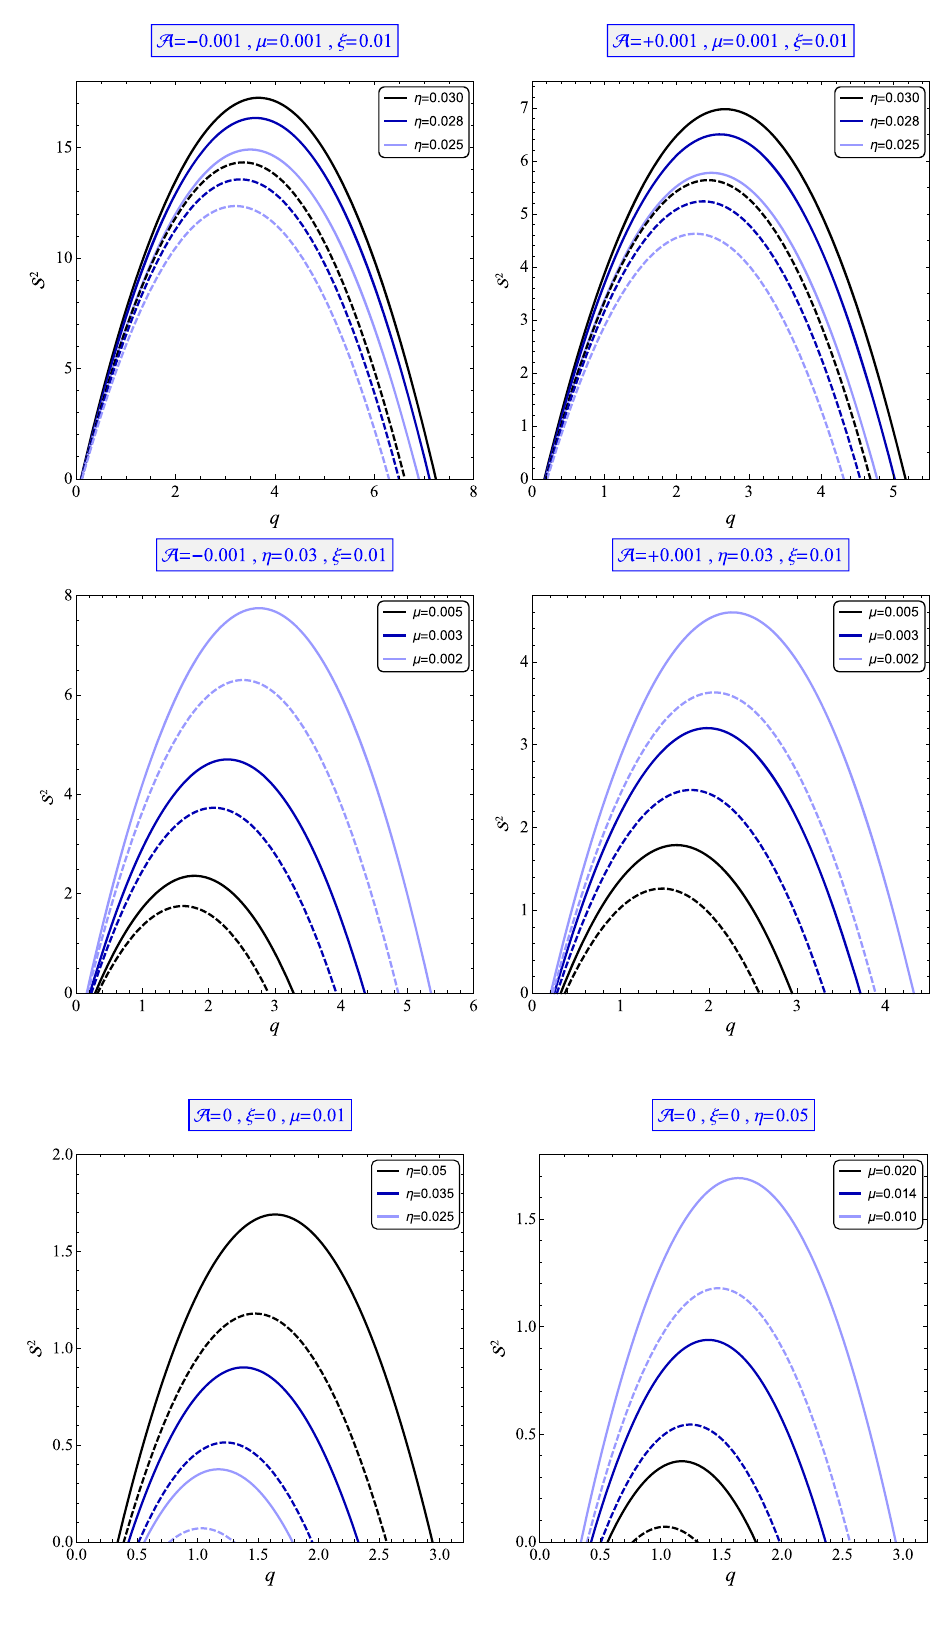
Fig. 4 Growth rate of small perturbations in the fluid disk in the context of EMSG